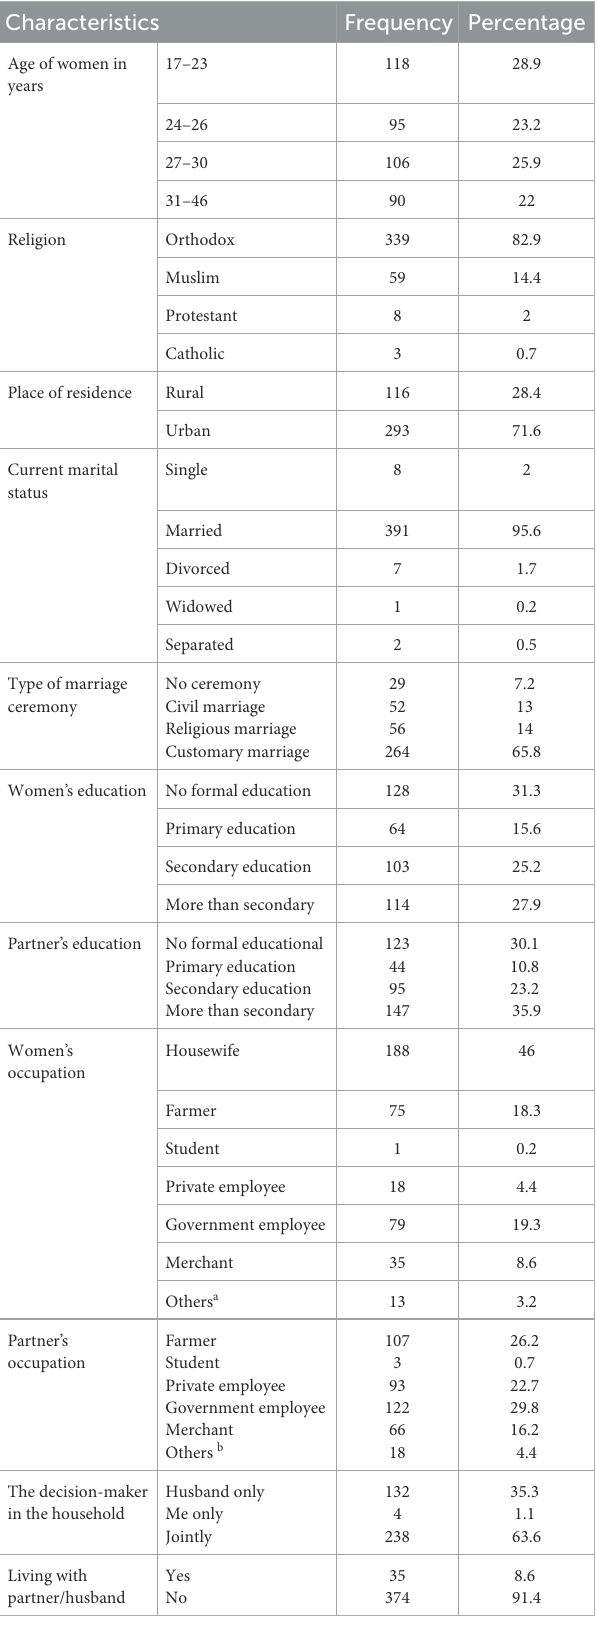
TABLE 1 Socio-demographic characteristics of the study participants ( n = 409).